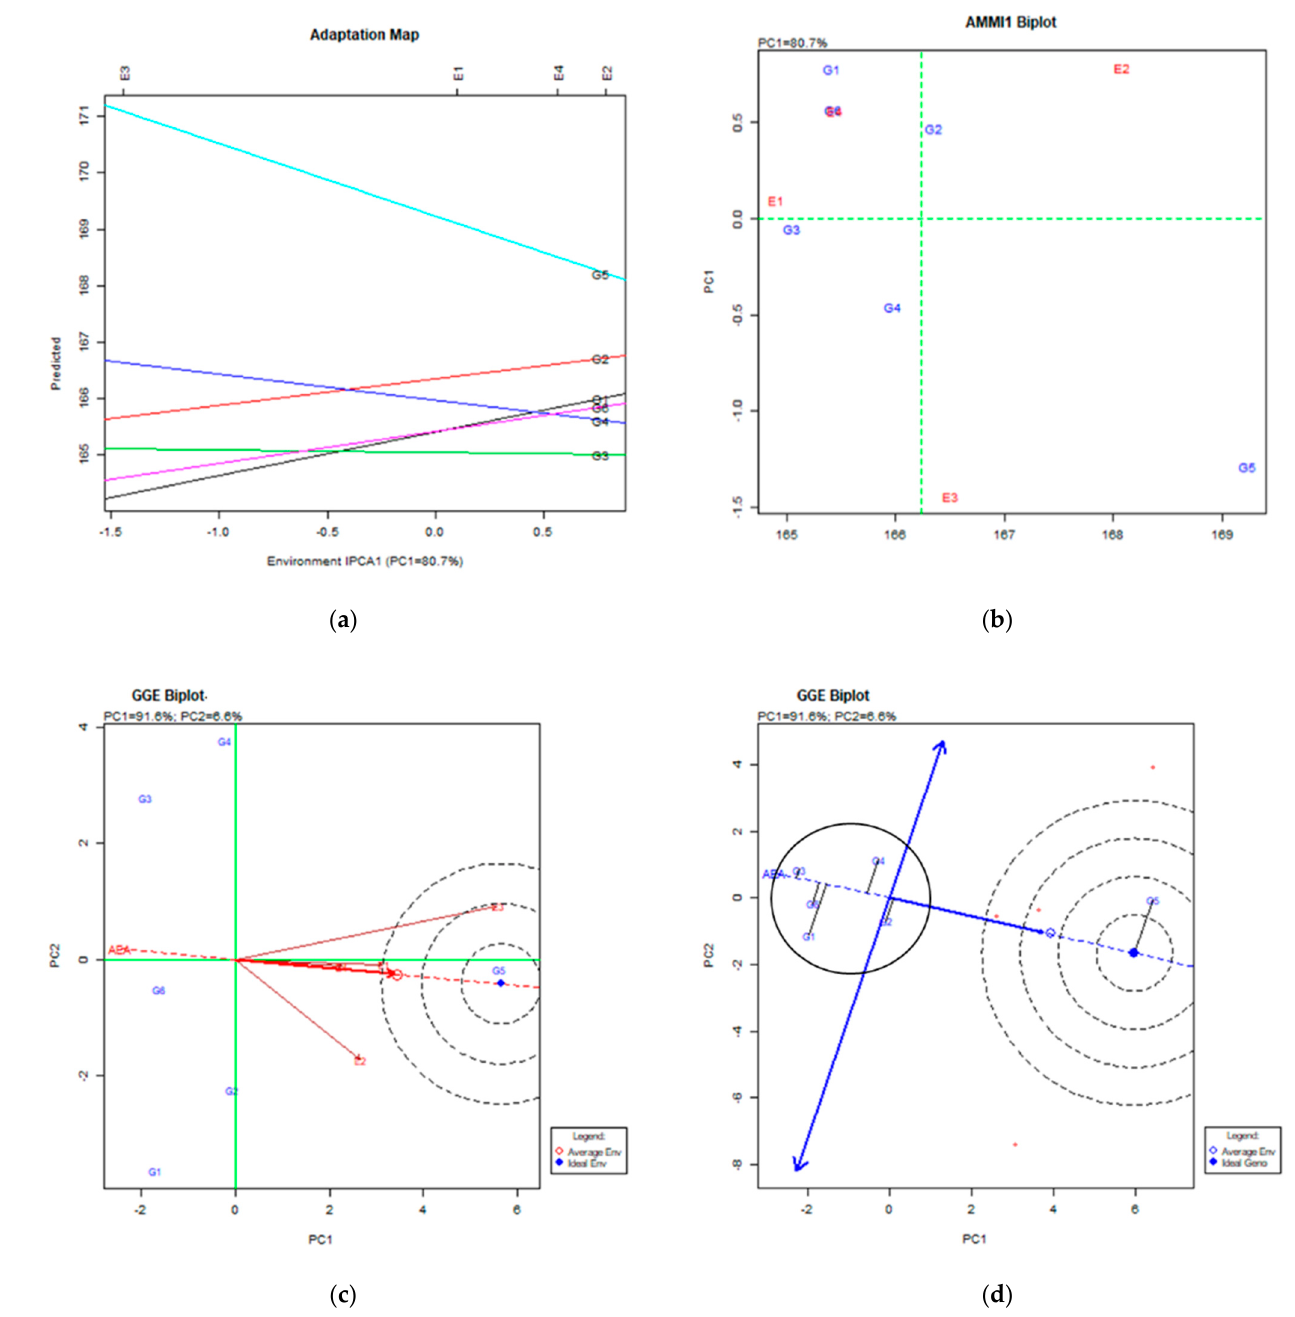
Figure 6. Stability analysis for days to 50% flowering based on: ( a ) the adaptation map where the X-axis (PC1) visualizes the stability of varieties over environments and the Y-axis—the performance of varieties for the trait; ( b ) the AMMI1 biplot where the Y-axis is the one visualizing the trait performance and the X-axis (PC1) visualizes the stability of varieties over environments; ( c ) the GGE biplot for environments depicting the stability of the environments over years via the placement as near as possible to the ideal and average environment; ( d ) the GGE biplot for varieties depicting the stability of the varieties over environments where the productive varieties are those to the right on the AEA vector and the stable ones are those which are as close to the AEA axis as possible.